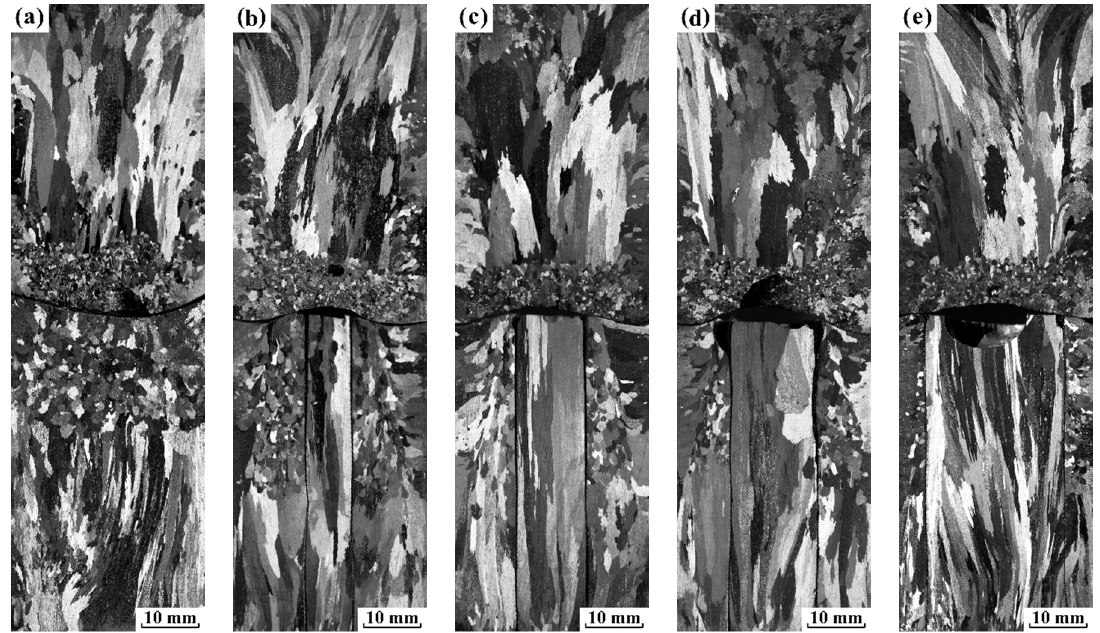
Figure 8. The solidification macrostructure along the longitudinal section of pure aluminum ingots under electropulsing with 900 A with mold of 34 mm embedded a mesh plate located in the middle of mold and a mesh tube of different diameter embedded along axis: ( a ) without the tube; ( b ) the tube of 8 mm; ( c ) the tube of 12 mm; ( d ) the tube of 16 mm and ( e ) the tube of 24 mm.